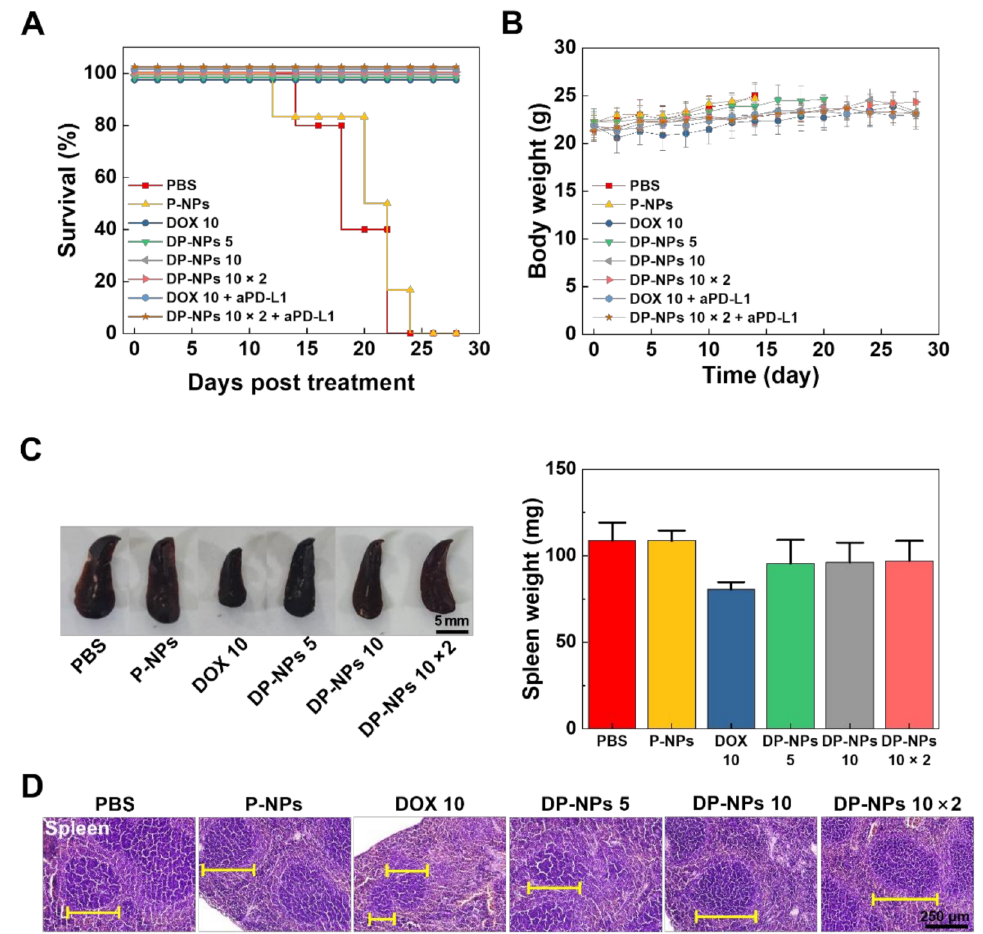
Figure 5. In vivo DOX-induced toxicity in the BALB/c mouse model. ( A ) Survival rate and ( B ) body weight change of the CT26 tumor-bearing mice after the first intratumoral injection of PBS, P-NPs, DOX-HCl (10 mg/kg), DP-NPs (5, 10, 10 × 2 mg/kg), aPD-L1 Ab (10 × 5 mg/kg)- combined DOX-HCl (10 mg/kg), and DP-NPs (10 × 2 mg/kg) for 4 weeks. ( C ) Representative photos and the weight of spleens from the CT26 tumor-bearing mice treated with PBS, P-NPs, DOX-HCl (10 mg/kg), DP-NPs (5, 10, 10 × 2 mg/kg) at 14 days after the first treatments. The scale bar indicates 5 mm. ( D ) Representative images of H&E-stained spleen tissues at 14 days after the first treatment of PBS, P-NPs, DOX-HCl (10 mg/kg), DP-NPs (5, 10, 10 × 2 mg/kg). Yellow line indicates the spleen white pulp (dark blue) in the H&E-stained histological images. The scale bar indicates 250 µ